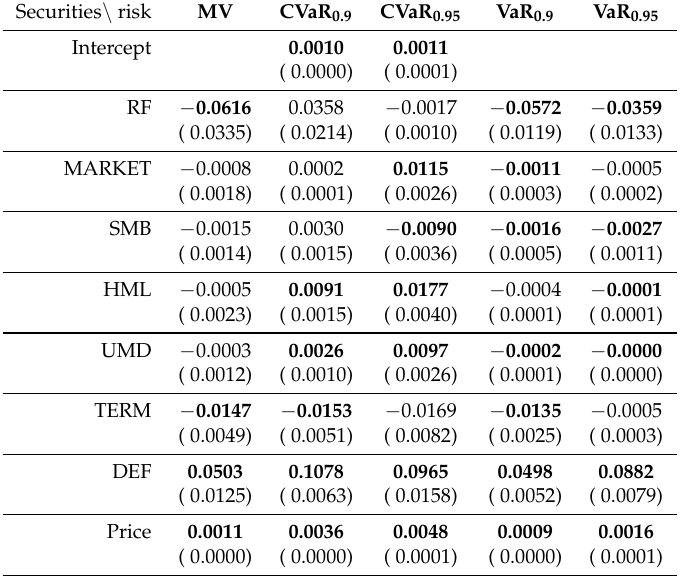
Table 4. Hedging of Default Spread. The table reports the estimates and their corresponding bootstrap errors (based on 400 bootstrap replications) for different risk measures (mean-variance MV, conditional value-at-risk CVaR, and value-at-risk VaR). The bold font represents statistical significance (at the 5% nominal level) of individual coefficients except for the last row where the bold font signifies a statistically different price from E ( y )